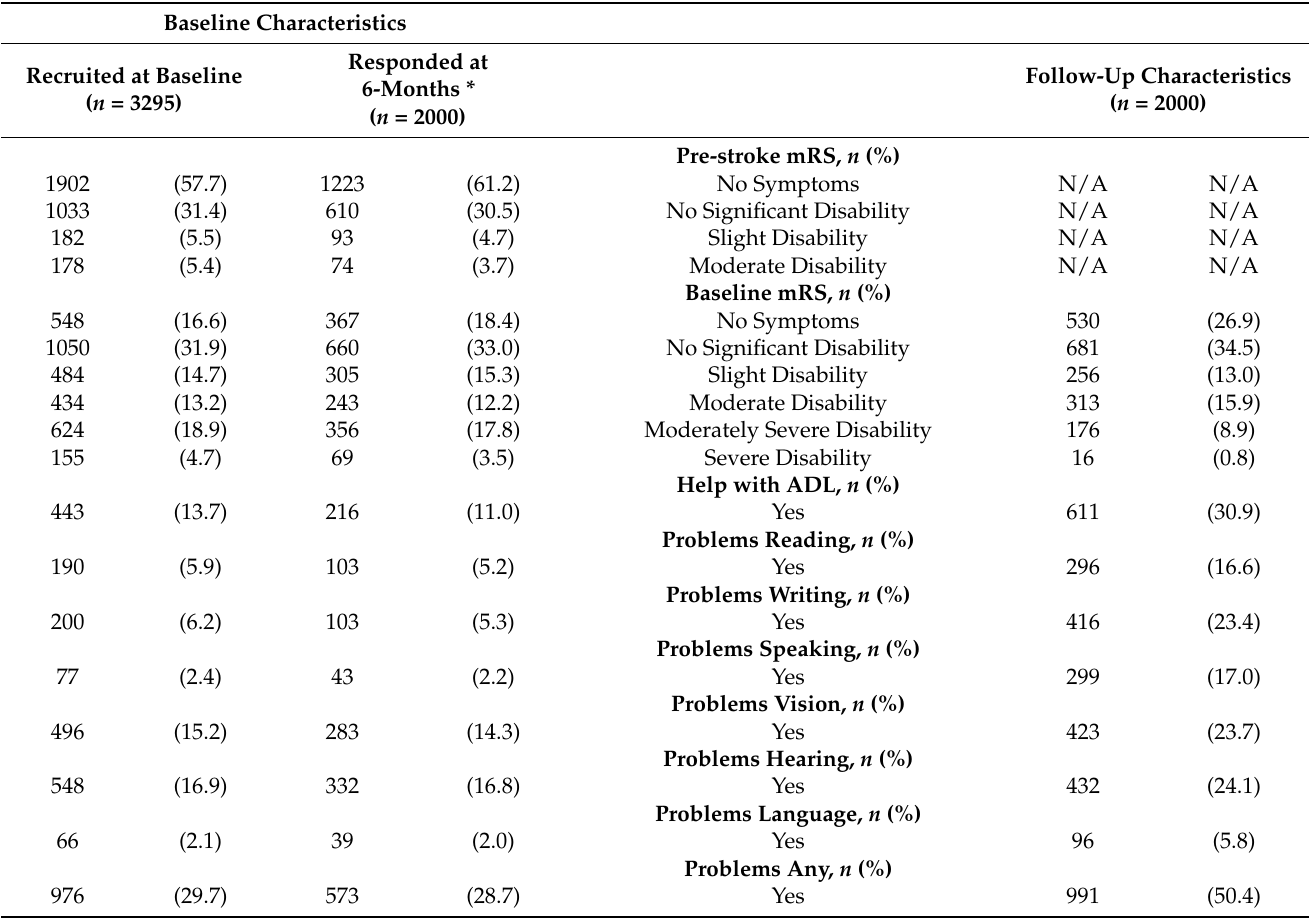
Table 2. Baseline health status for participants analysed at baseline, 6-months and 6-month